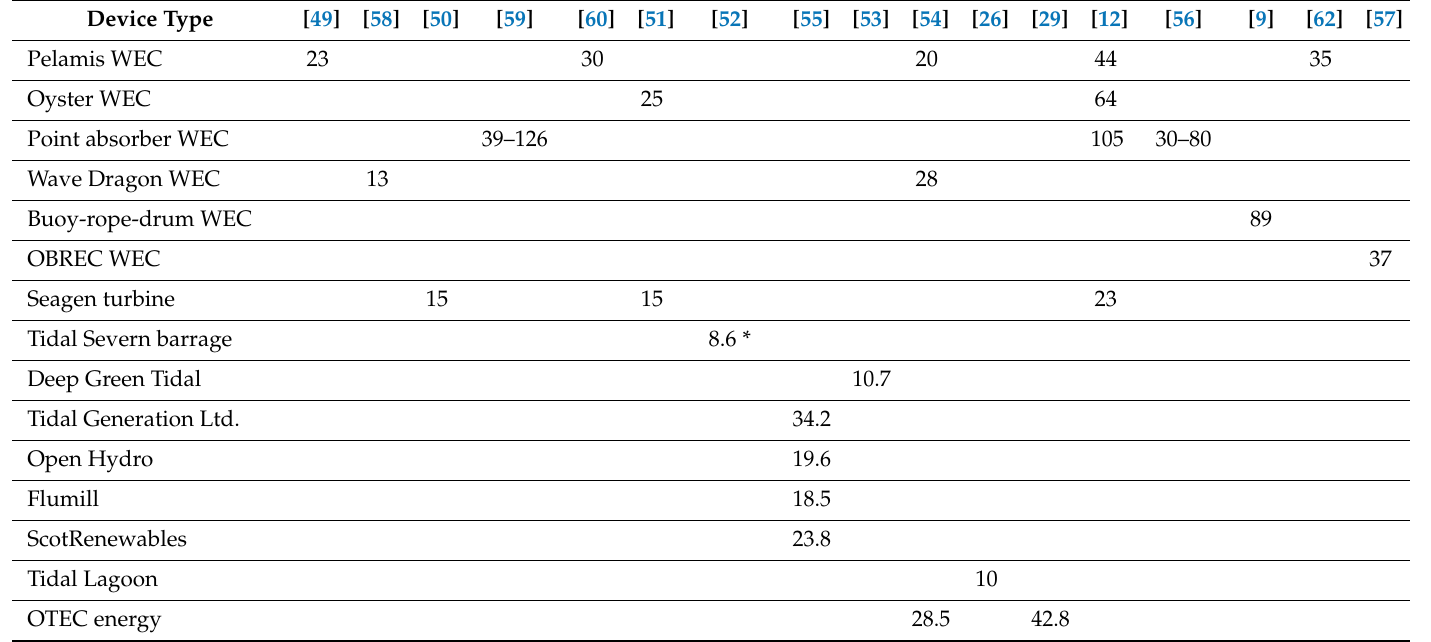
Table 3. Emission of gases in term of g CO 2 eq / kWh by ocean energy devices. Device